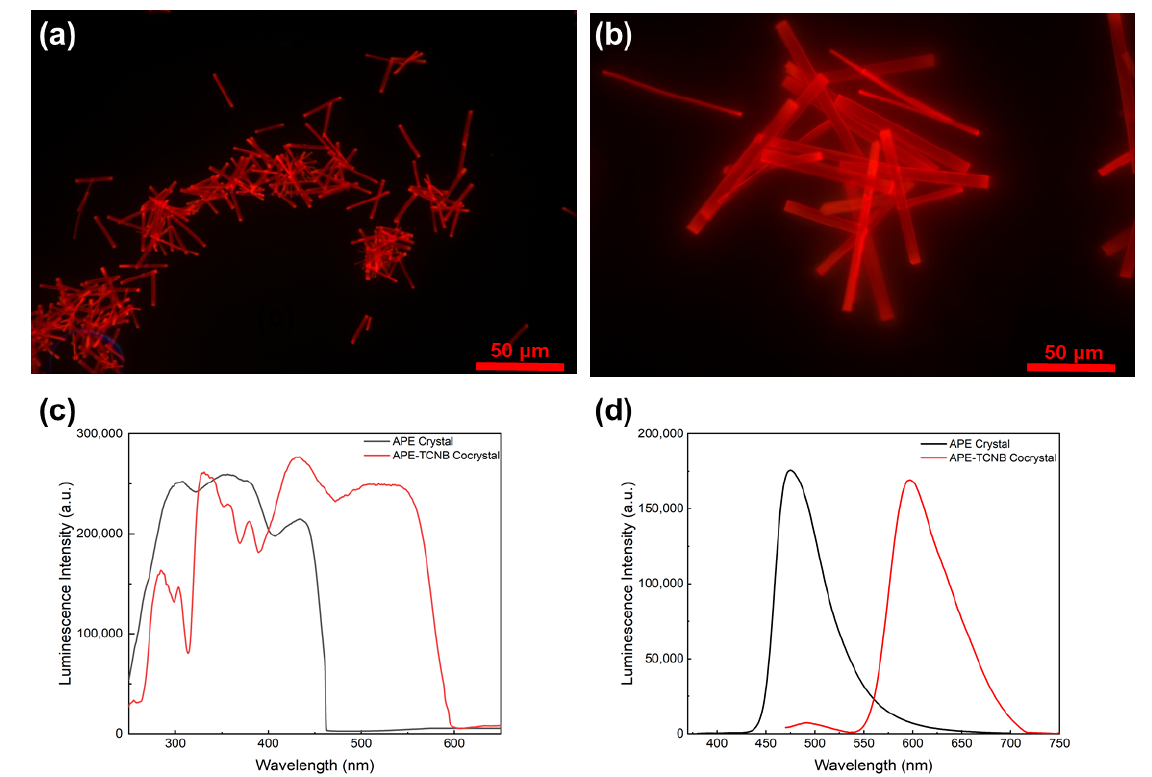
Figure 6. ( a , b ) Fluorescence microscopy images of the APE-TCNB cocrystals with different sizes illuminated by 405 nm light; ( c ) fluorescence excitation spectra of APE crystals and APE-TCNB cocrystals (emission at 650 nm); ( d ) fluorescence emission spectra of APE crystals (excited at 360 nm) and APE-TCNB cocrystals (excited at 450 nm).